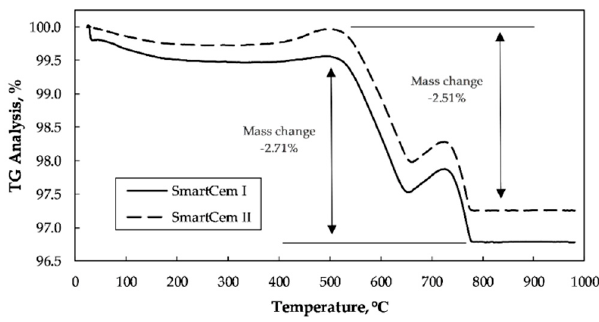
Figure 7. TG Analysis of SmartCem I and SmartCem II.